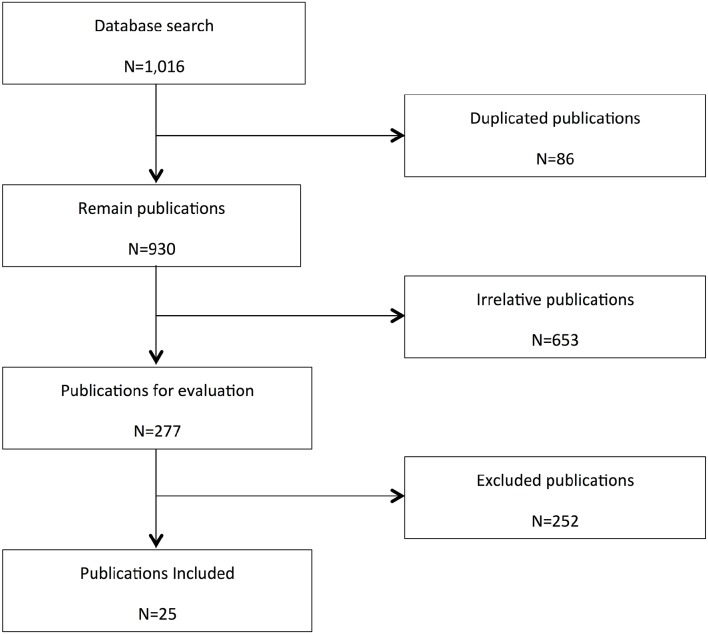
Flow chart for study retrieval and selection. In vitro studies, interaction studies including mixtures of CBD with other cannabis extracts, studies not assessing haemodynamics (BP, HR, or BF), review articles and editorials, or uncontrolled studies were excluded.